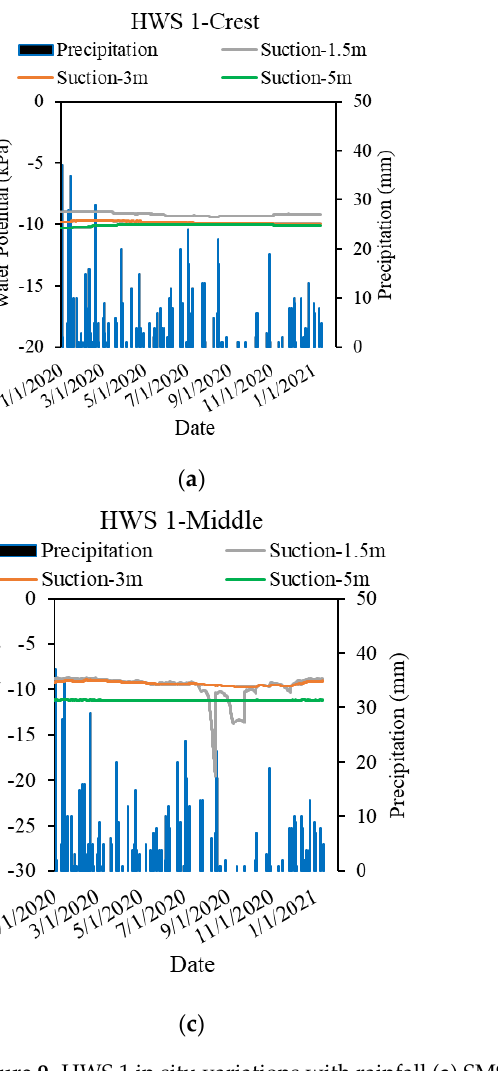
Figure 9. HWS 1 in situ variations with rainfall ( a ) SMS across the crest of the slope ( b ) VSMC across the crest of the slope ( c ) SMS across the middle of the slope ( d ) VSMC across the middle of the slope (1 m = 3.28 ft; 1 mm = 0.039 in; 1 kPa = 20.89 psf).